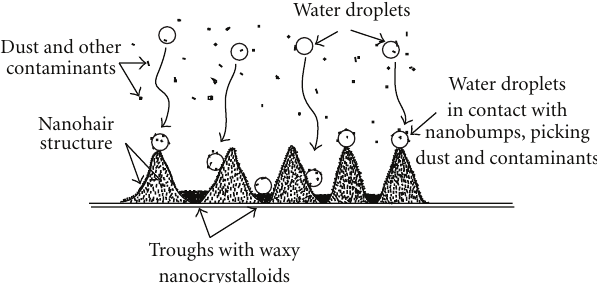
Figure 6: Schematic of superhydrophobic surface showing nanobumps and waxy troughs.